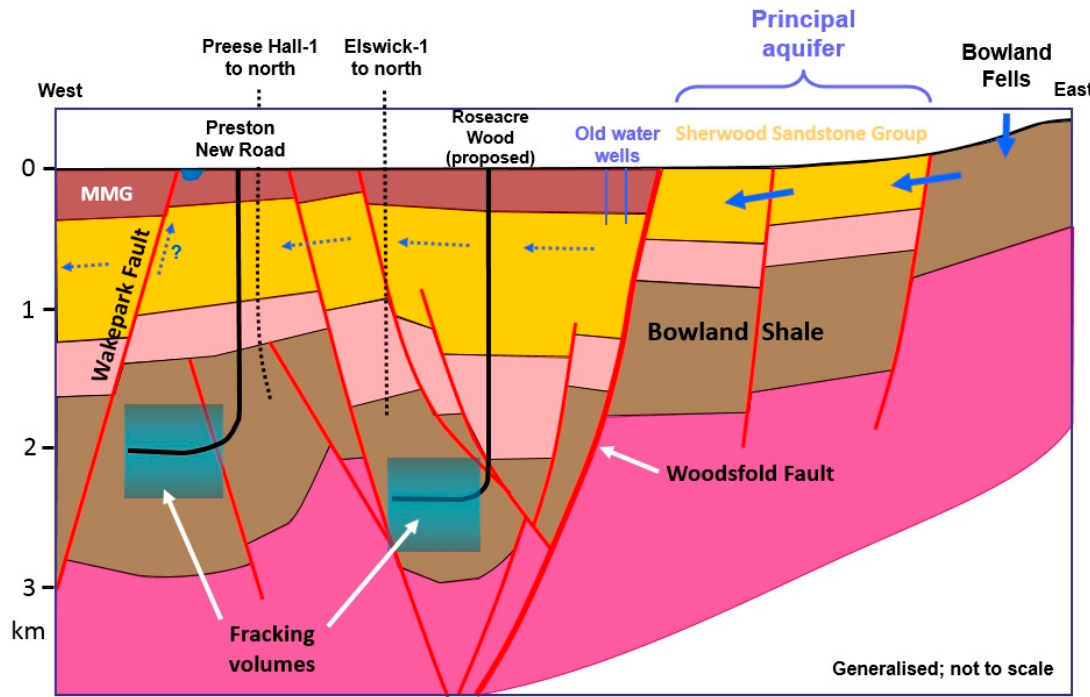
Figure 8. Schematic cross-section across the Fylde, showing the unconfined Sherwood Sandstone Group principal aquifer (SSG; yellow) east of the Woodsfold Fault, but confined below the Mercia Mudstone Group (MMG; rust-brown) west of the fault. The Bowland-Hodder Group (shale) is shown in light brown, the pink layer is the combined Manchester Marls (upper) and Collyhurst Sandstone (lower). Roseacre Wood was a proposed Cuadrilla fracking site. The Wakepark Lake is indicated by the blue cup shape adjacent to the Wakepark Fault.